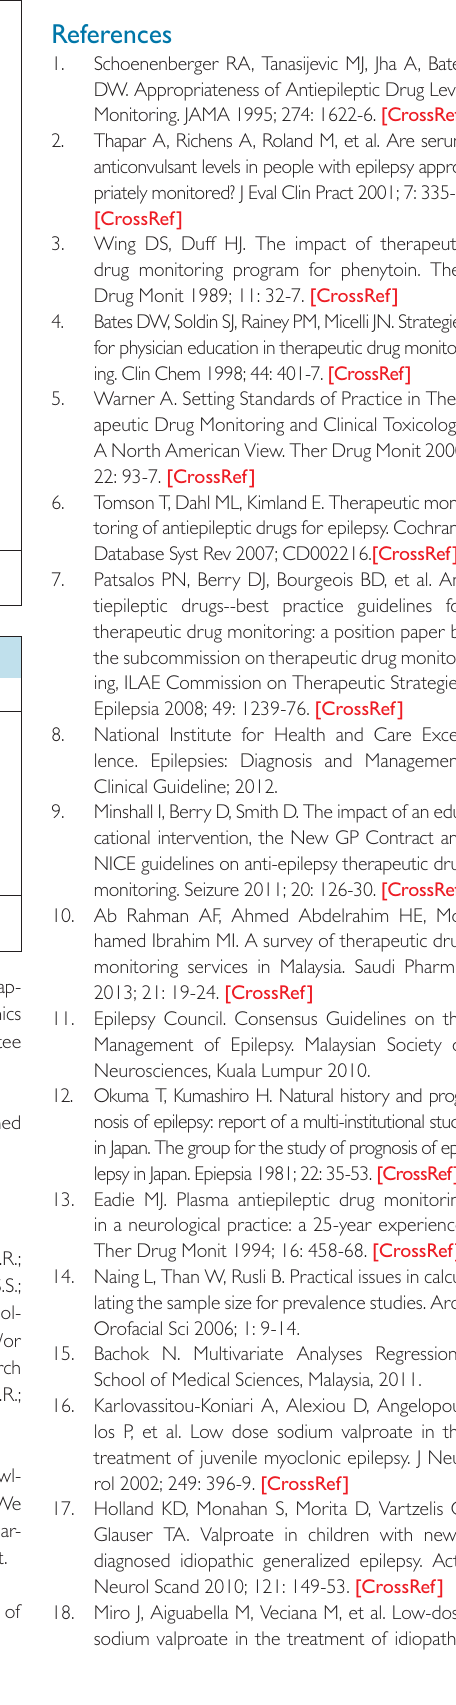
Table 2. Univariate analysis of predicting factors for good seizure control (n=242) (continue) Variables